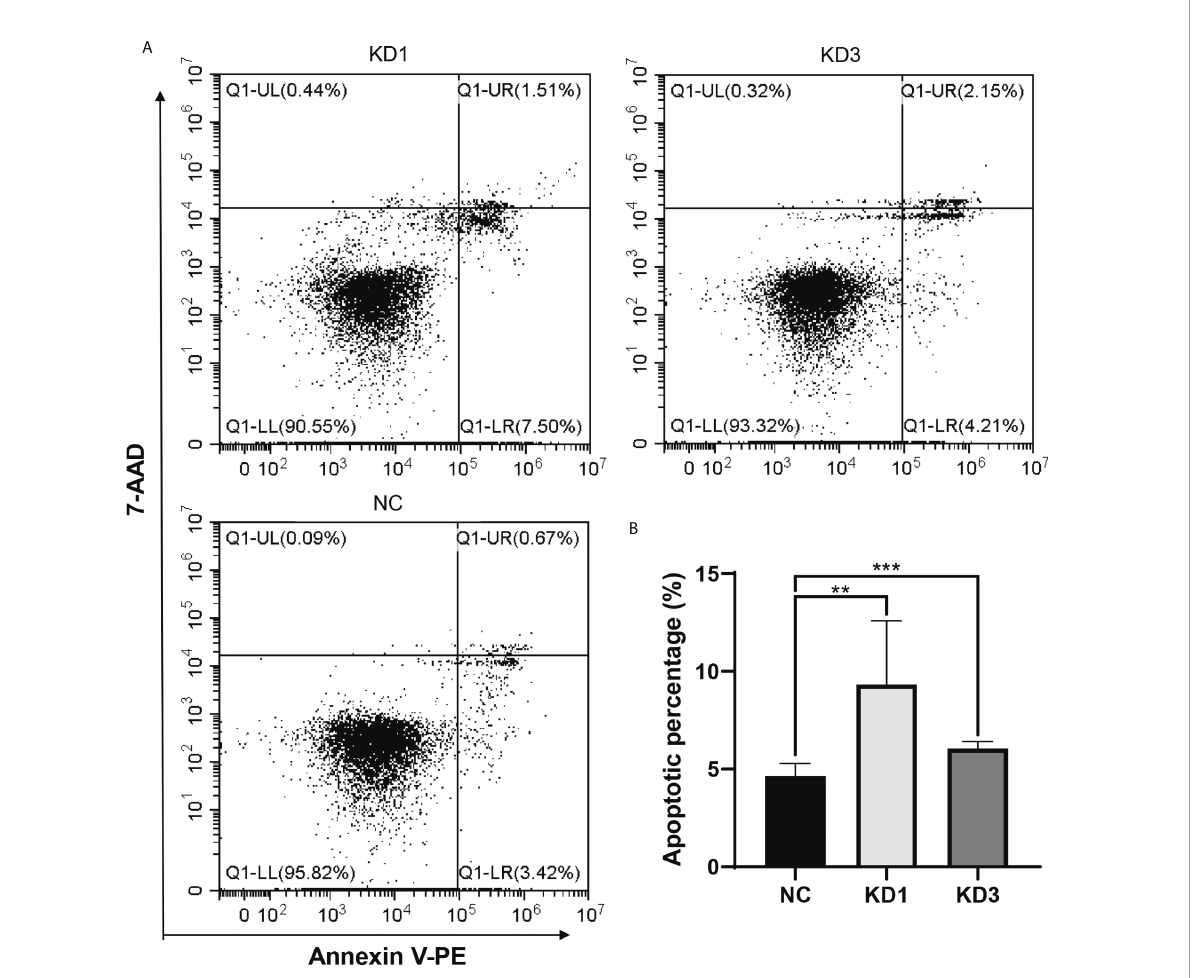
FIGURE 5 Effect of La RNAi on apoptosis of A2780 cells: (A) The apoptosis in A2780 cells of the KD1, KD3, and NC groups. (B) The percentage of apoptotic cells in the NC, KD1, and KD3 groups. The value was expressed as the mean ± standard deviation of three independent samples (** P < 0.05, *** P <